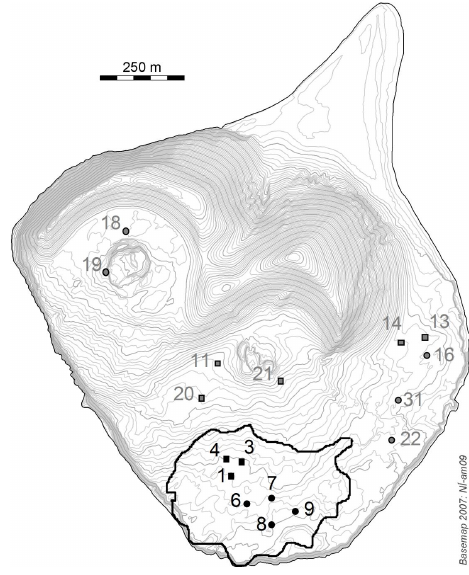
Fig. 1. Location of the permanent study plots on Surtsey that were used in this study, shown on a topographical map from 2007. Contour intervals are 2m, the highest point on the island is 152m a.s.l.. The Eastern crater is located close to plots 18 and 19, the Western crater is located close to plot 21. North of the craters, a high rim of palagonite tuff was formed. The dense vegetation within the seabird colony in 2012 is marked with a black line (approximation from aerial and satellite images, by Anette Th. Meier; Magnússon et al., 2014). Grey is outside seabird colony; black is inside colony; squares are deep tephra sand; circles are shallow tephra